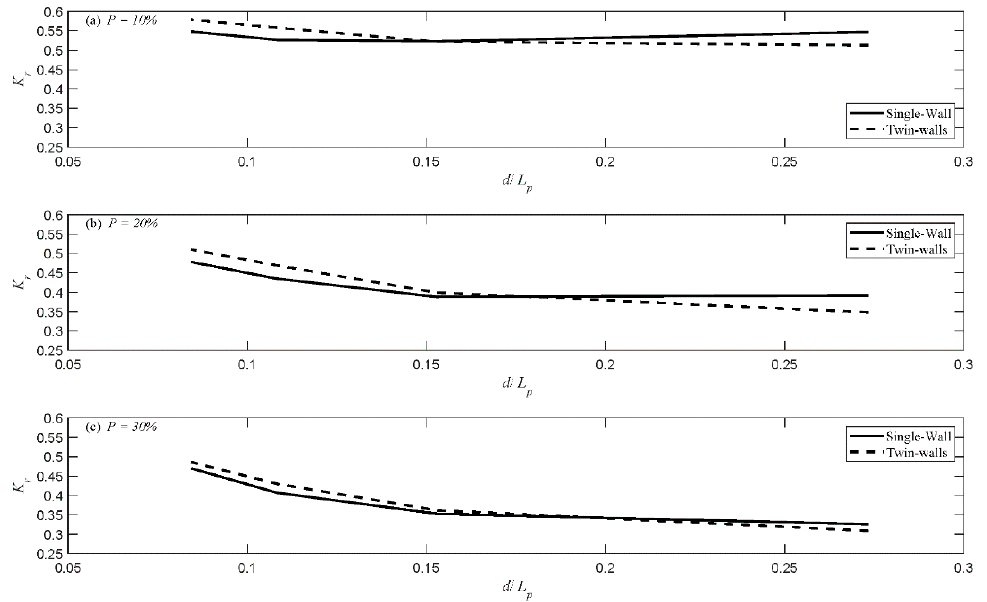
Figure 12. Effect of the number of walls on K r . θ = 90°, and H is / d = 0.1284. ( a ) P = 10%, ( b ) P = 20%, and ( c ) P = 30%.